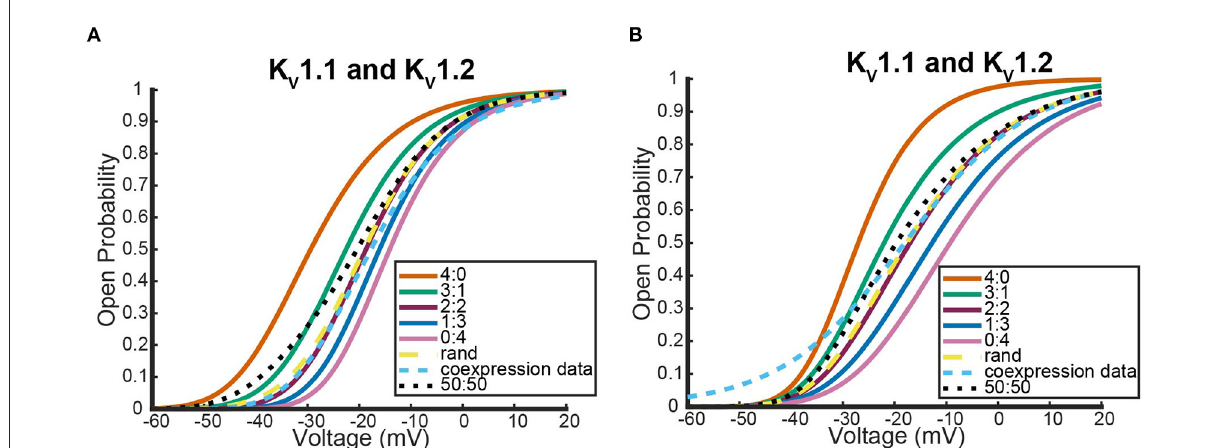
FIGURE6 Steady state probability curves as a function of voltage for cells containing various channel types in two different experiments. The coexpression data and homomeric data for model fitting was taken from D’Adamo et al. (1999) (A) and Imbrici et al. (2008) (B) . The steady state probability curves presented here are for homomeric K v 1.1 (4:0) and K v 1.2 (0:4) channels, heteromeric K v 1.1 / 1.2 channels (3:1, 2:2, 1:3), the model output of a random assembly of K v 1.1 and K v 1.2 subunits expressed in 50:50 ratio (rand), the data output of a 50:50 expression of K v 1.1 and K v 1.2 cDNAs (coexpression data), and a model output of an equal split between only homomeric channels (50:50). Curve color and type are shown in the legends. Homomeric channels and their related heteromers being looked at are also detailed in figure